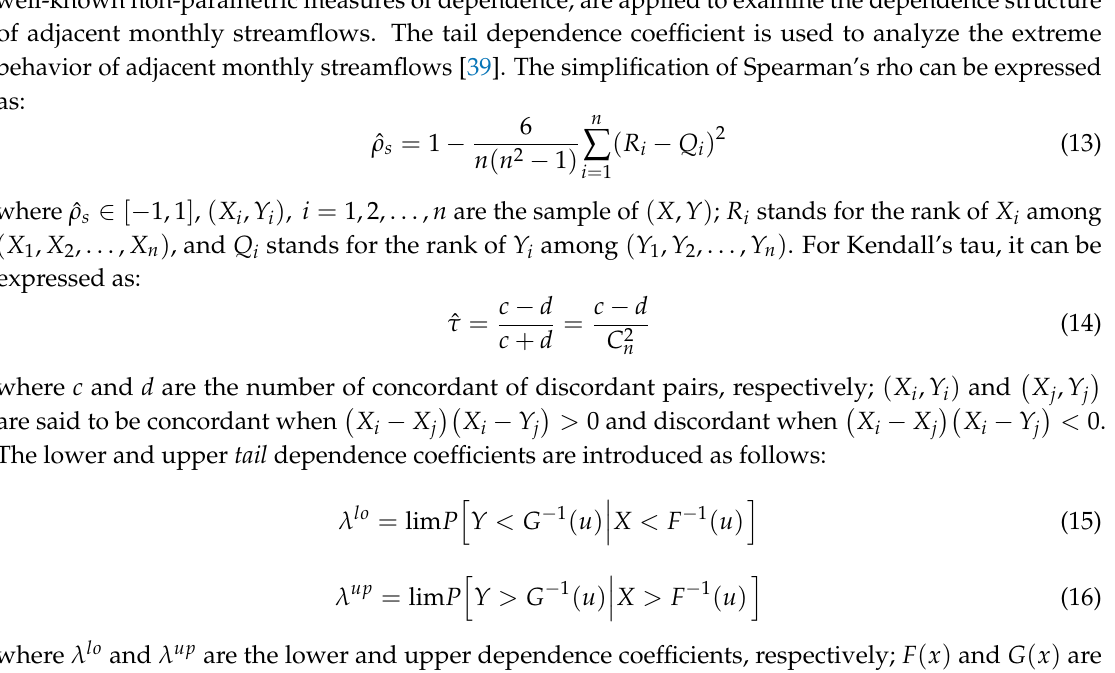
Figure 3. Trend of monthly streamflow from 1957 to 2009.